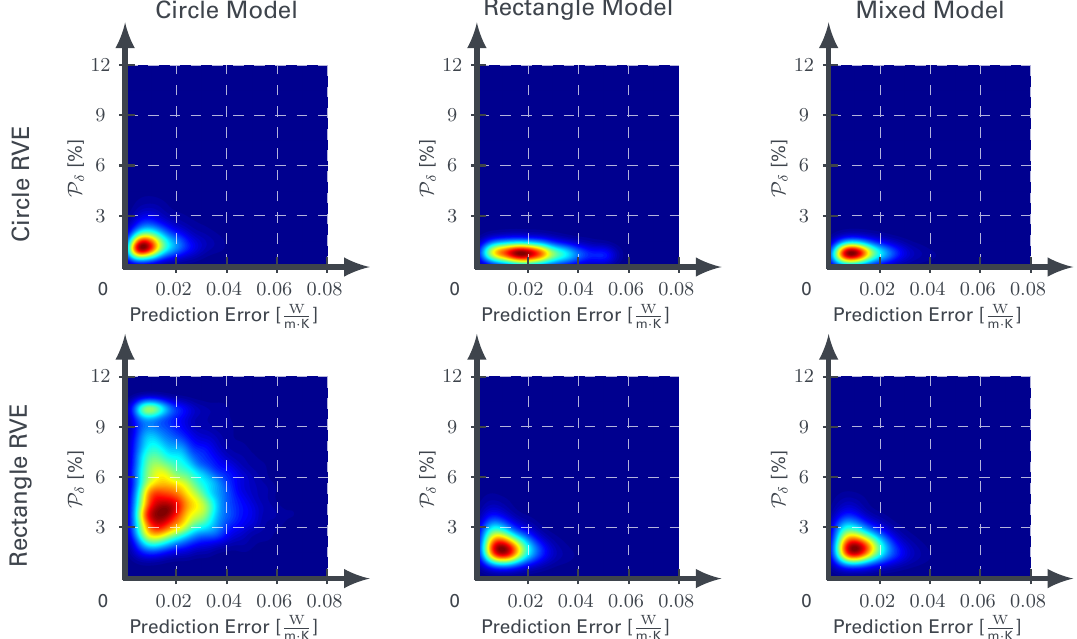
Figure 10. A density map of the projection error of the reduced basis compared to the prediction error of the ANN is given for all of the three training variants, for the prediction of the circle and rectangle test set, respectively. Each with one exemplary ANN (basis dimensions are 23, 25 and 25, respectively, from left to